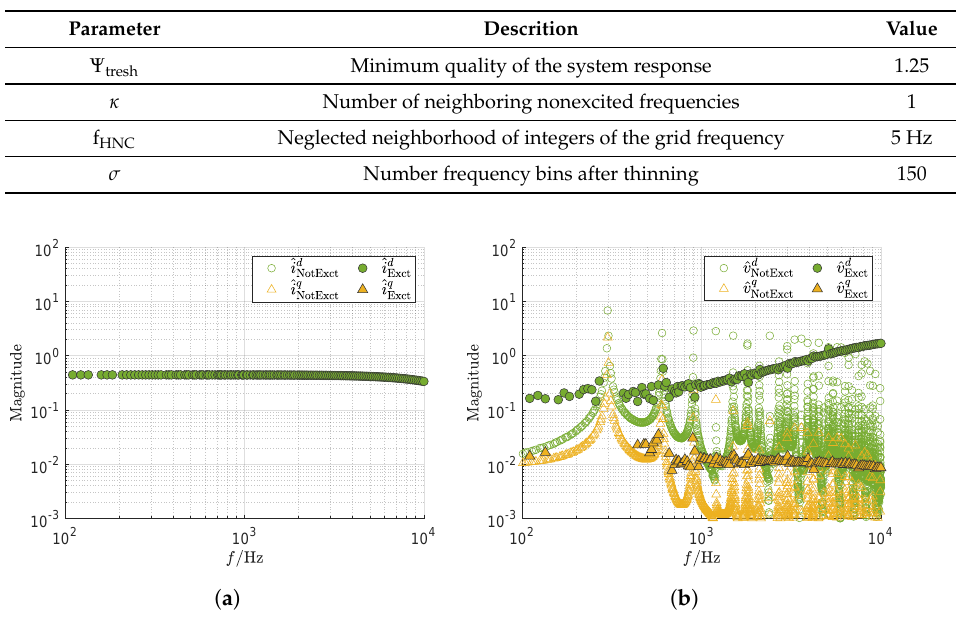
Figure 20. Compensated realistic impedance measurement scenario during excitation of the d -axis. ( a ) Spectrum of the current i meas in the dq domain. ( b ) Spectrum of the voltage v meas in the dq